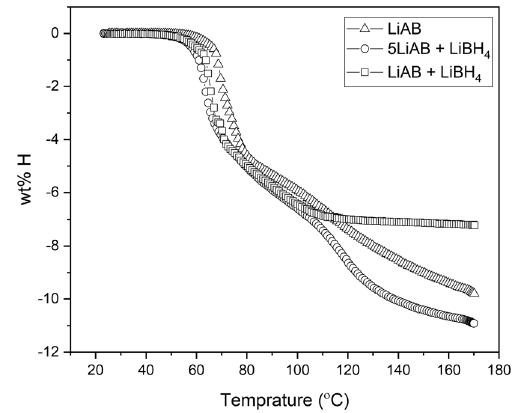
Fig. 4 Dynamic thermal decomposition of 5LiNH 2 BH 3 + LiBH 4 (open circle), LiNH 2 BH 3 + LiBH 4 (open square) and pure LiNH 2 BH 3 (open triangle) under 1 bar hydrogen pressure (heating rate 1 °C min −1 in Sievert